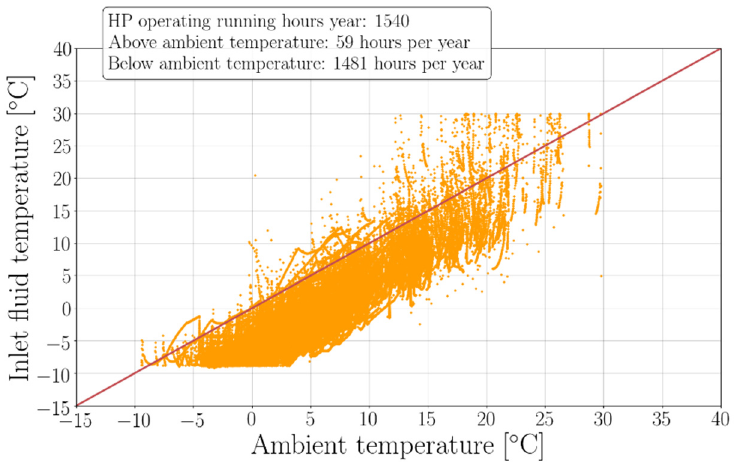
Figure 16. Ambient air temperature versus the inlet fluid temperature at the inlet the source side of the heat pump. the heat pump.